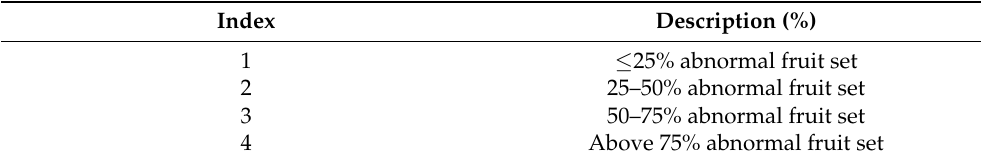
Table 1. Rating index of fruit set